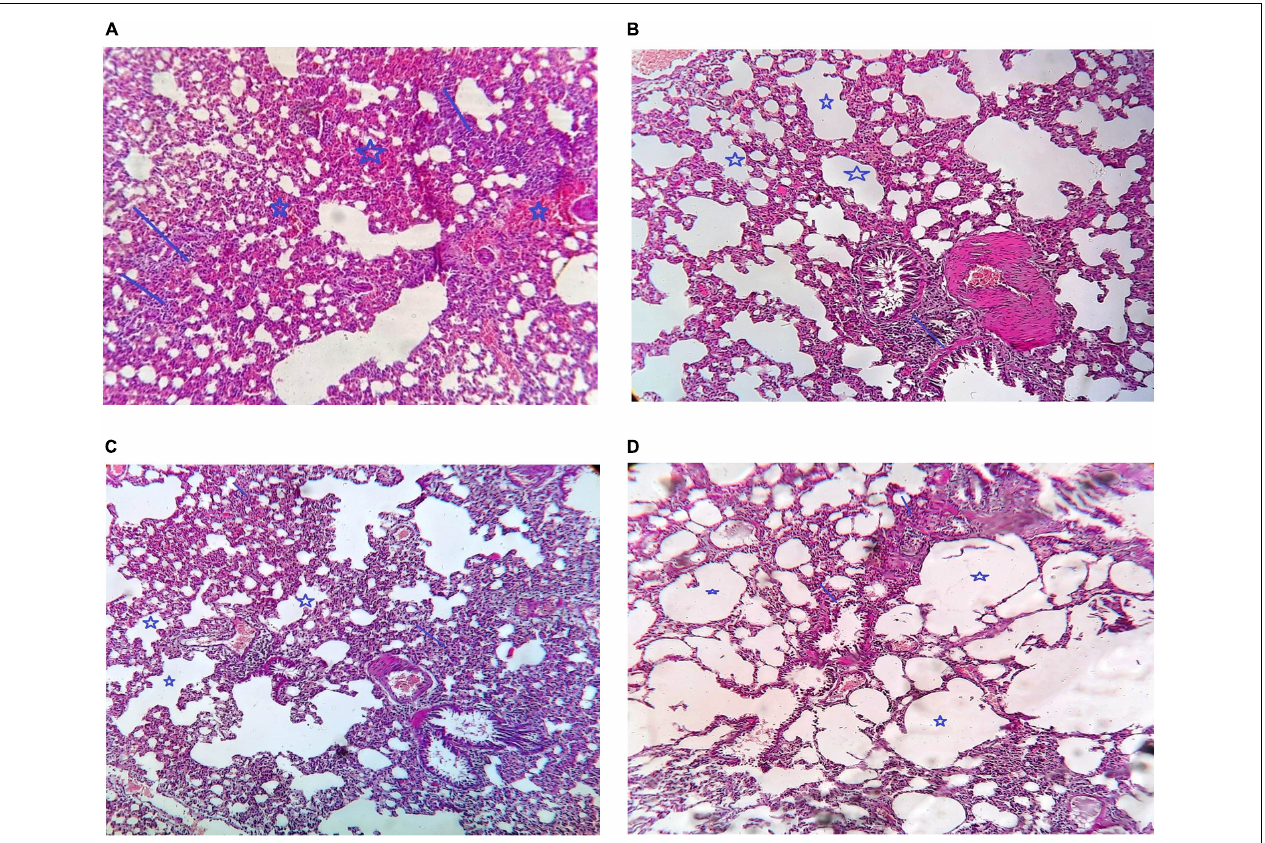
FIGURE 6 | Histological examination of different groups of rat lungs. (A) PN group, Arrow show multiple foci of moderate inflammatory infiltrate. Star showed marked intraalveolar congestion, (B) VIT C group: Arrow showed that there is alveoli are still congested and contain inflammatory infiltrate but less than that in case of pneumonia only. Star showed that there is some alveoli are cleared from congestion and inflammatory infiltrate, (C) AB group: Arrow show moderate peribroncheal inflammatory infiltrate. Star show alveoli cleared from congestion and inflammatory infiltrate, (D) VIT C+ AB group: Arrow showed there is no peribronchial inflammatory infiltrate. Star showed cleared alveoli with no congestion or